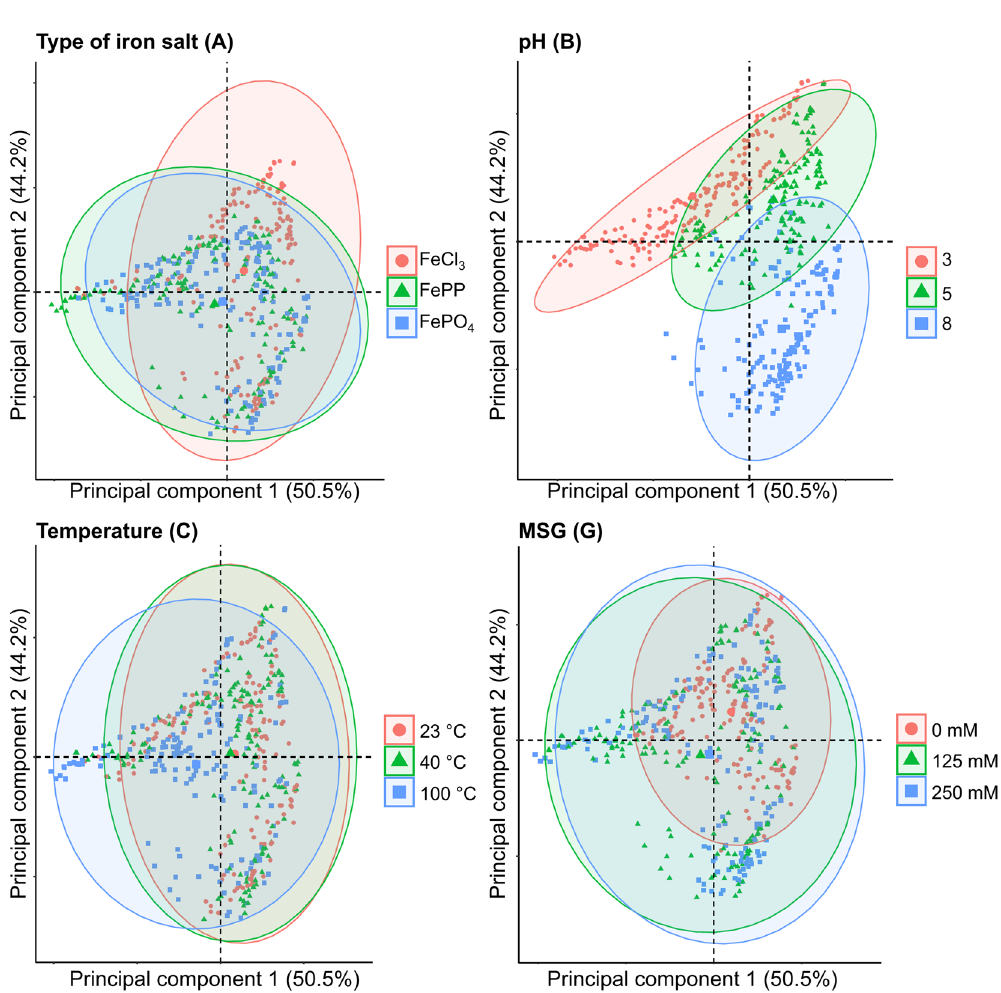
Figure 2. PCA biplots showing the principal component scores based on the normalised absorbance spectra, with colour indication for the different levels of the factors: type of iron salt ( A ), pH ( B ), temperature ( C ), and MSG ( G